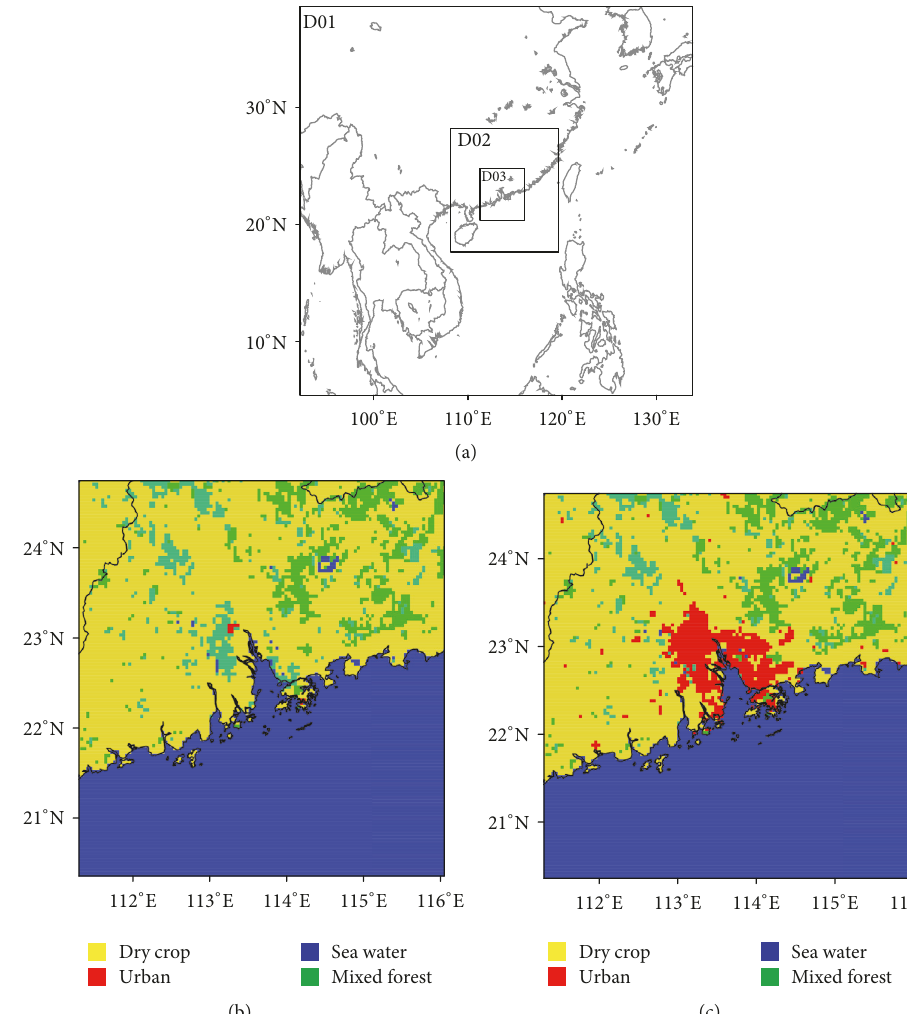
Figure 1: WRF model nested domains and land use for simulations. (a) WRF nested domains. Domain 1 (D01): 36-km grid spacing; Domain 2 (D02): 12km spacing; Domain 3 (D03): 4 km spacing. (b) USGS 1992-1993 data used in PRE-URBAN test D03. (c) MODIS 2001 data in URBAN test